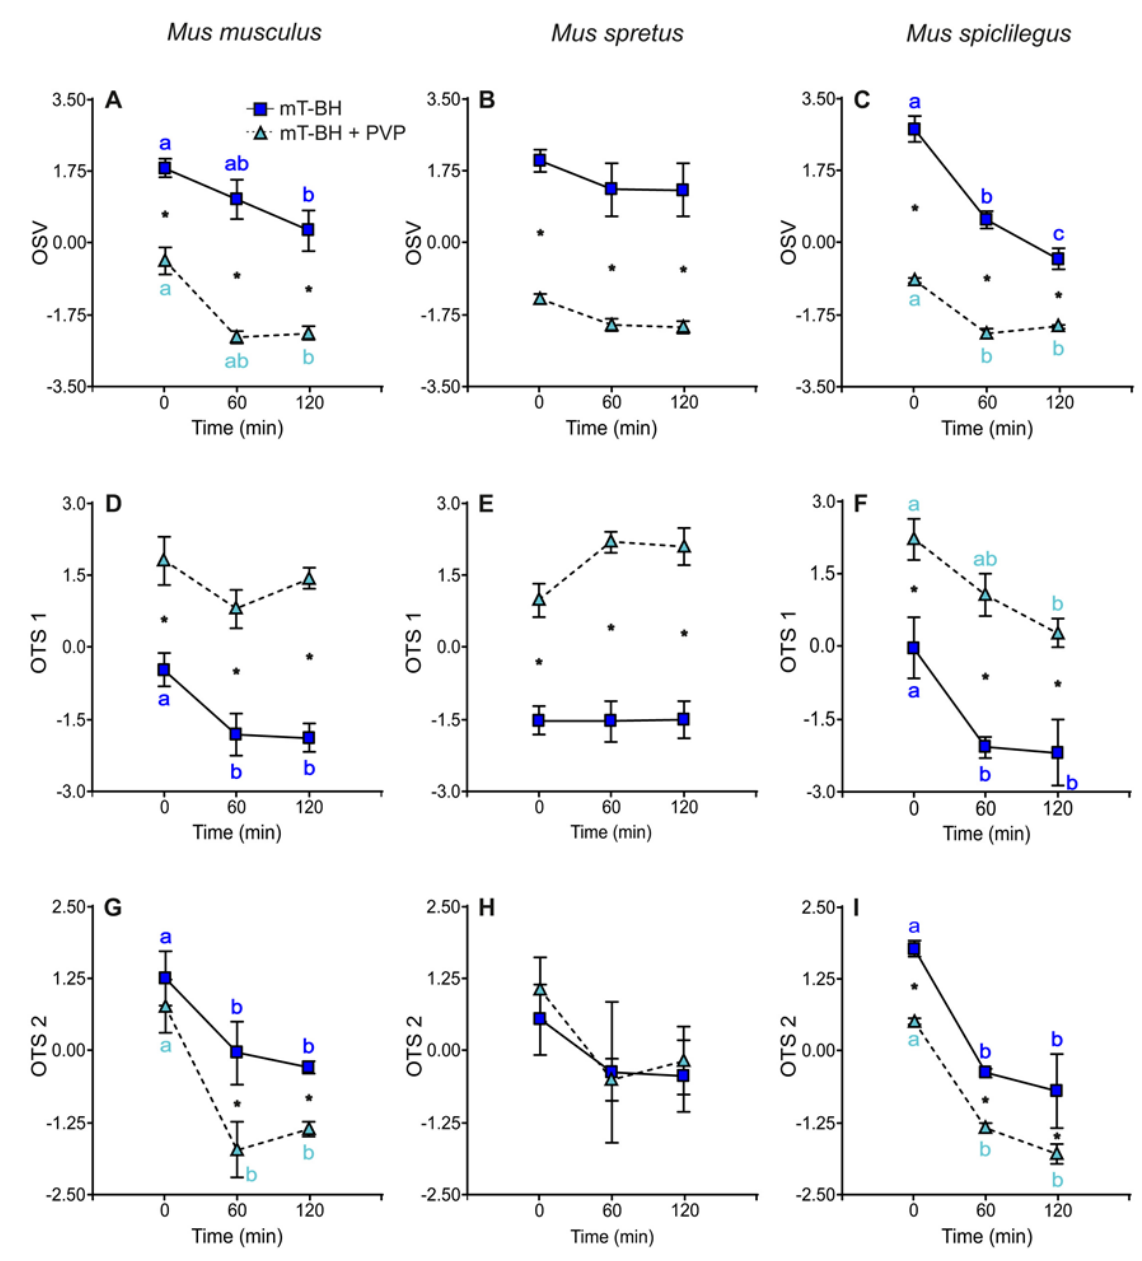
Figure 4. Variation in the principal components of swimming: OSV, OTS 1, and OTS 2 over time in sperm incubated in capacitating conditions in low viscosity (mT − BH medium under 5% CO 2 /air) and high viscosity (mT − BH + PVP medium under 5 % CO 2 /air). Data are means ± SE ( M. musculus : N = 4; M. spretus : N = 5; M. spicilegus : N = 4). ( A – C ): OSV1. ( D – F ): OTS 1. ( G – I ): OTS 2. ( A , D , G ): M. musculus . ( B , E , H ): M. spretus . ( C , F , I ): M. spicilegus . Dark blue squares and letters: capacitating conditions in low viscosity (mT − BH). Light blue triangles and letters: capacitating conditions in high viscosity (mT − BH + PVP). Asterisks indicate significant differences between viscosity treatments for the same time point in a Fisher post-hoc test ( p < 0.05). Different letters indicate significant differences between time points for the same viscosity treatment in a Fisher post-hoc test ( p < 0.05). With regards to trajectories of sperm incubated under capacitating conditions, results showed that sperm in low viscosity exhibited values of OTS 1 that were lower than those in sperm incubated in 2% PVP in the three species (Figure 4D,F; Table 5). OTS 1 showed a significant decrease from 0 to 60 min in sperm incubated in low viscosity in M. musculus and M. spicilegus (Figure 4D,F; Table 5). Sperm incubated in high viscosity showed a linear decrease in OTS 1 throughout the incubation period in M. spicilegus but remained stable